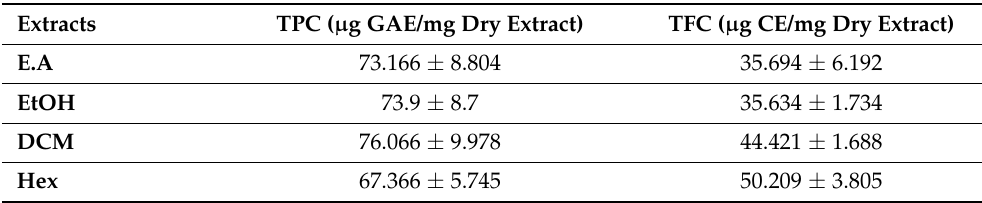
Table 1. Total phenolic and flavonoids contents of ethyl acetate, ethanolic, dichloromethane and hexanic extracts of Cistus ladanifer .